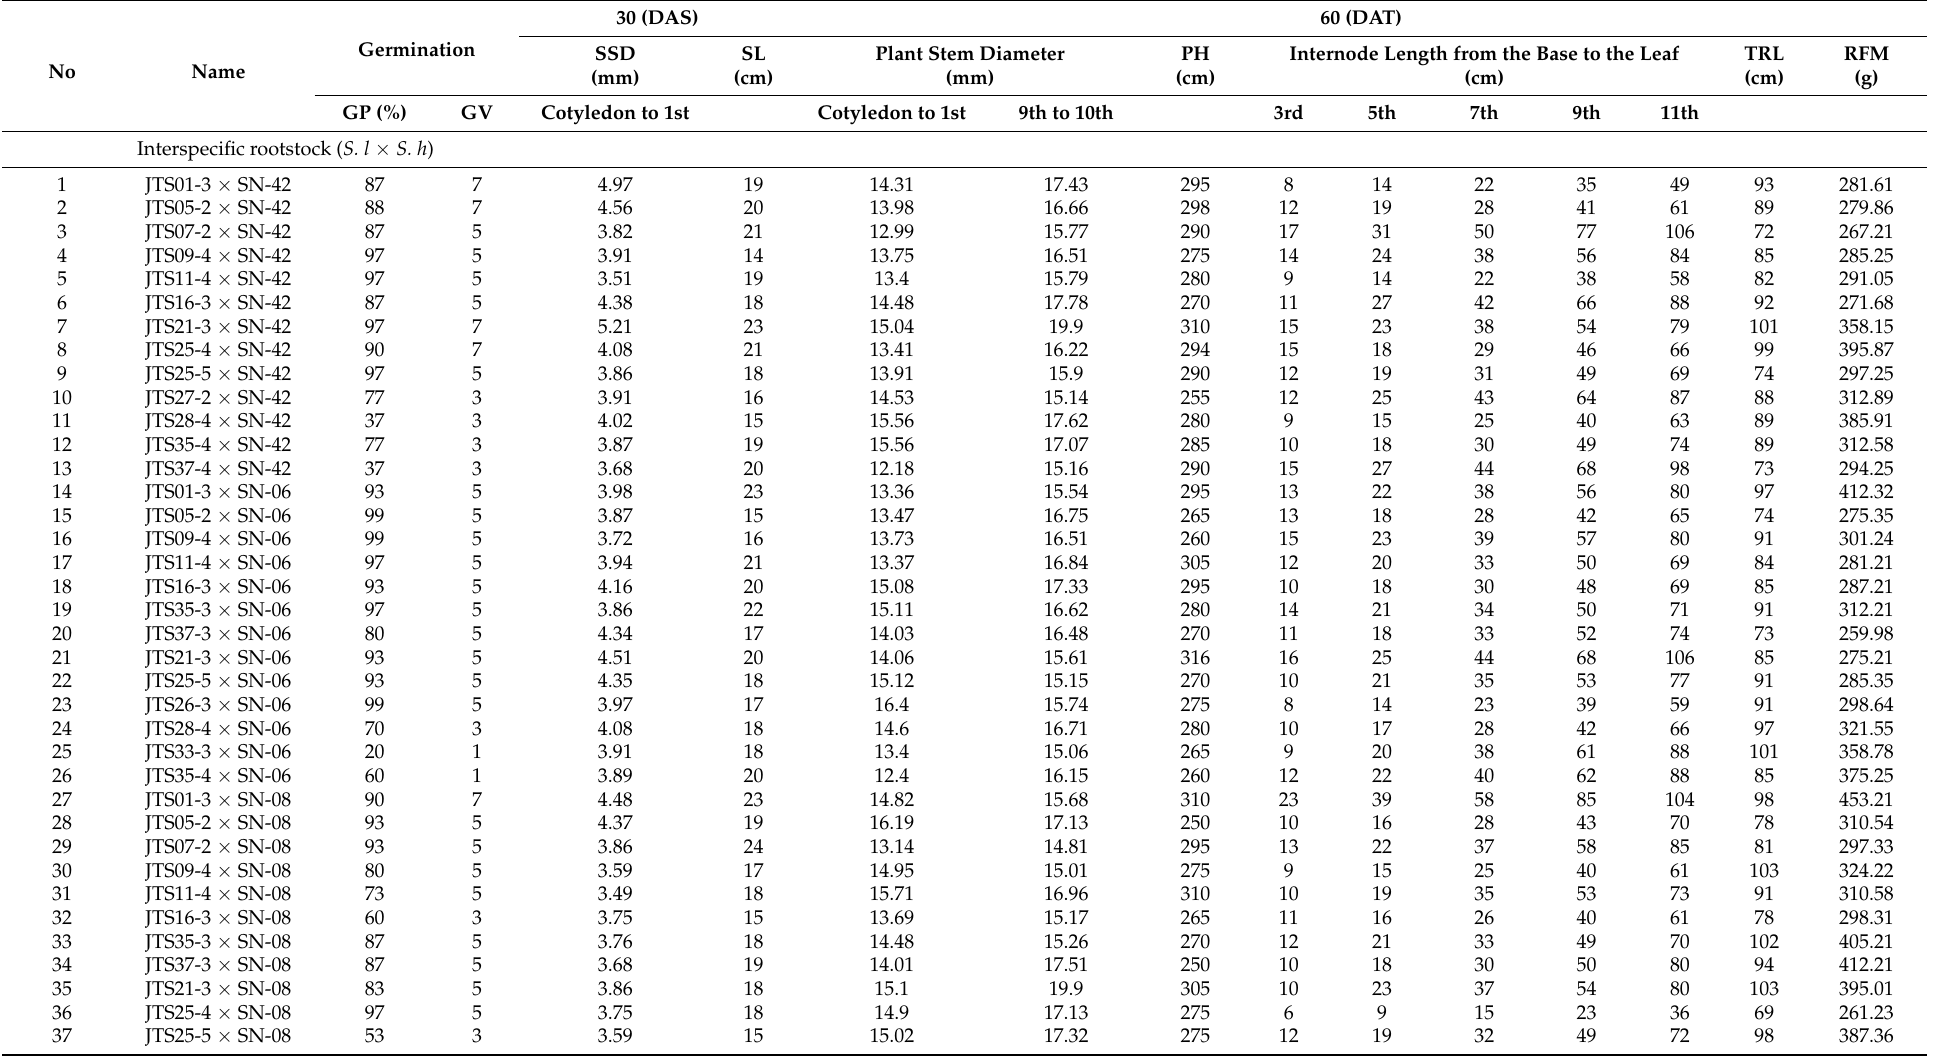
Table 4. List of horticultural traits of hybrid new combinations and commercial rootstock